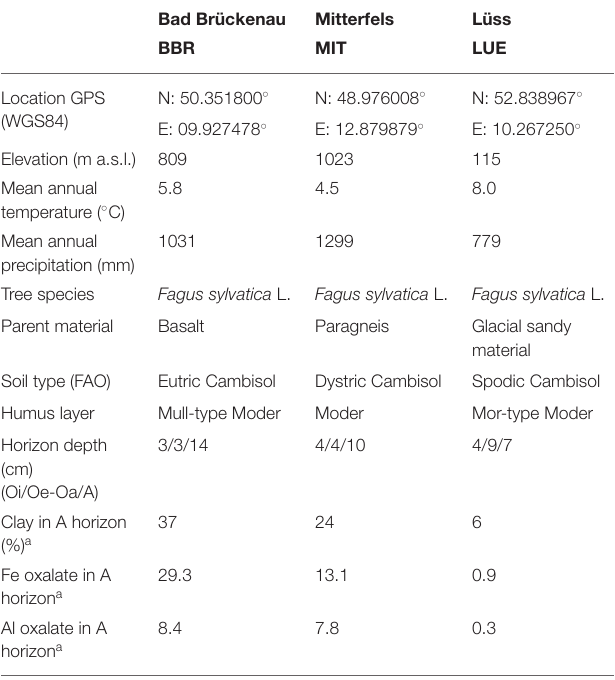
TABLE 1 | Characteristics of the three study sites Bad Brückenau (BBR), Mitterfels (MIT), and Lüss (LUE), representing a natural gradient in P availability. Bad